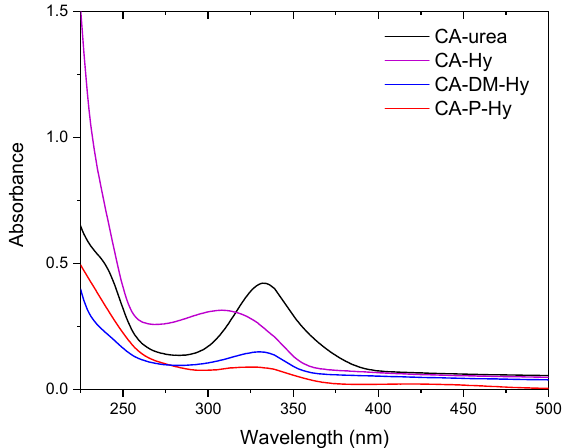
Figure 1. Absorption spectra of the hydrazine-based compounds compared to urea-derived carbon dots (CDs).